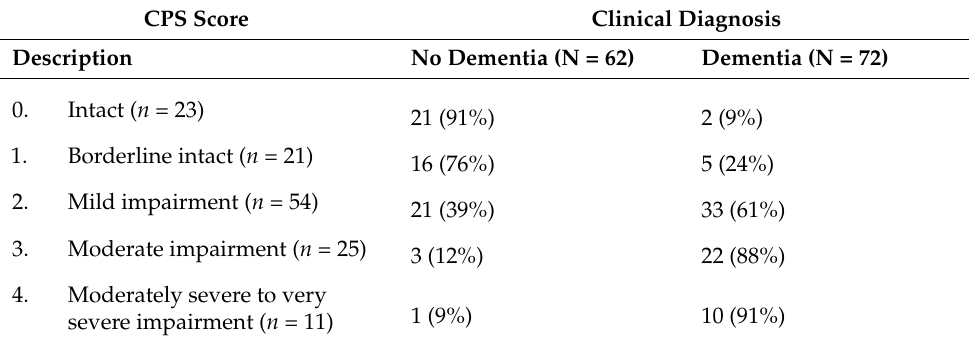
Table 1. Clinical diagnosis of dementia and no dementia by CPS score ( n =